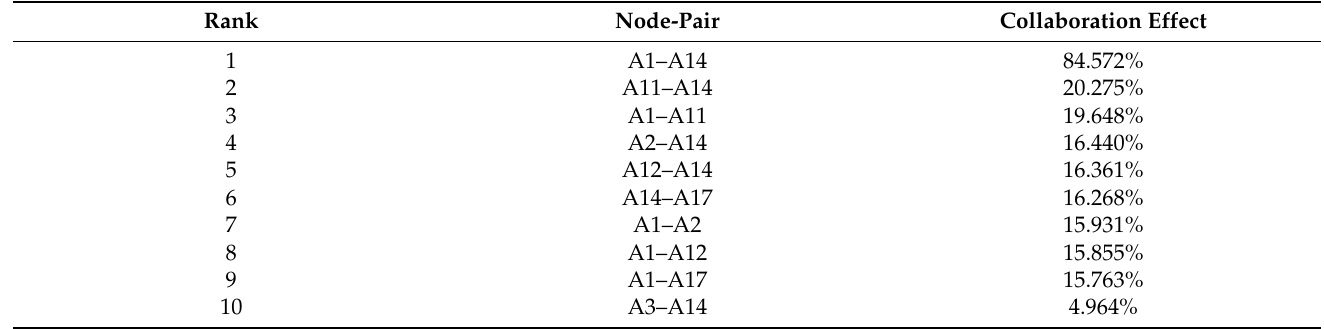
Table 7. The top 10 collaboration effect values and the corresponding node-pairs (retaining three decimal